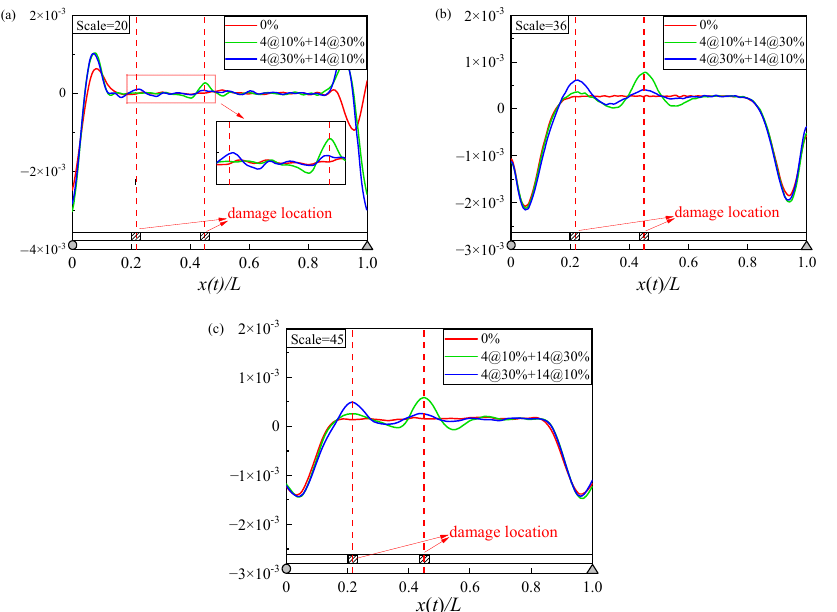
Figure 10. Inspection of multi ‐ damage case: ( a ) CWC extracted from bridge mid ‐ span acceleration; ( b ) CWC extracted from vehicle acceleration; ( c ) CWC extracted from contact ‐ point acceleration. Where @ indicates the degree of damage.